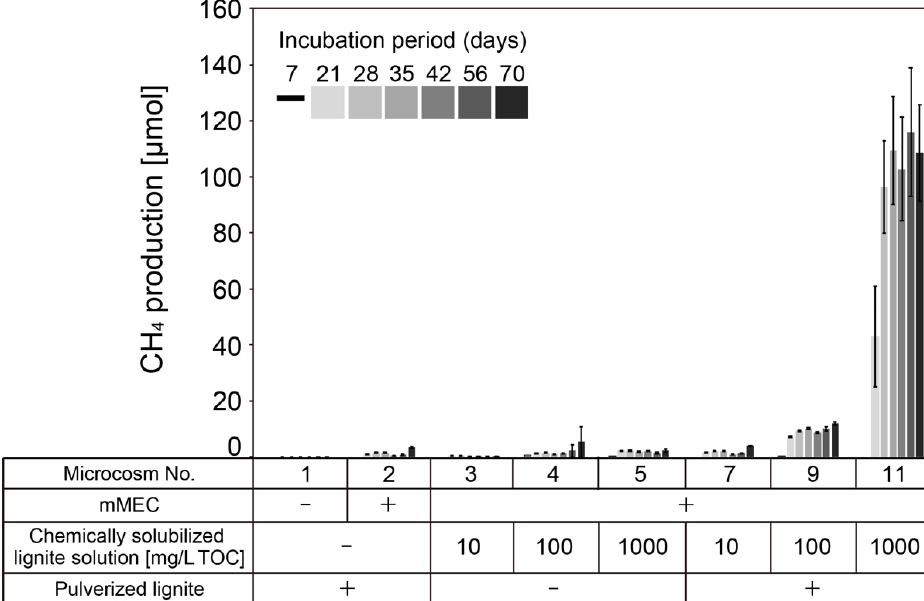
Figure 2. Methane production in the microcosms using mMEC. Values are the mean of three replicates indicating the amount of methane that accumulated in the headspaces of the culture tubes (please refer to Supplementary Table S2). Errors bars (where visible) represent the standard deviation. Microcosm numbers correspond to those in Figures 3 and 6, and Supplementary Tables S2, S3, and S6. The results of microcosms No. 6, 8, and 10 were not shown because mMEC was not added to those microcosms (no methane production was observed). − , not added or absent; +, added or present.